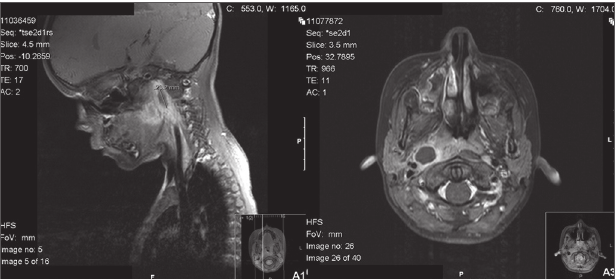
Figura 2. A. Abscesso látero-faríngeo (RM, incidência sagital). B. Abscesso látero-faríngeo (RM, incidência